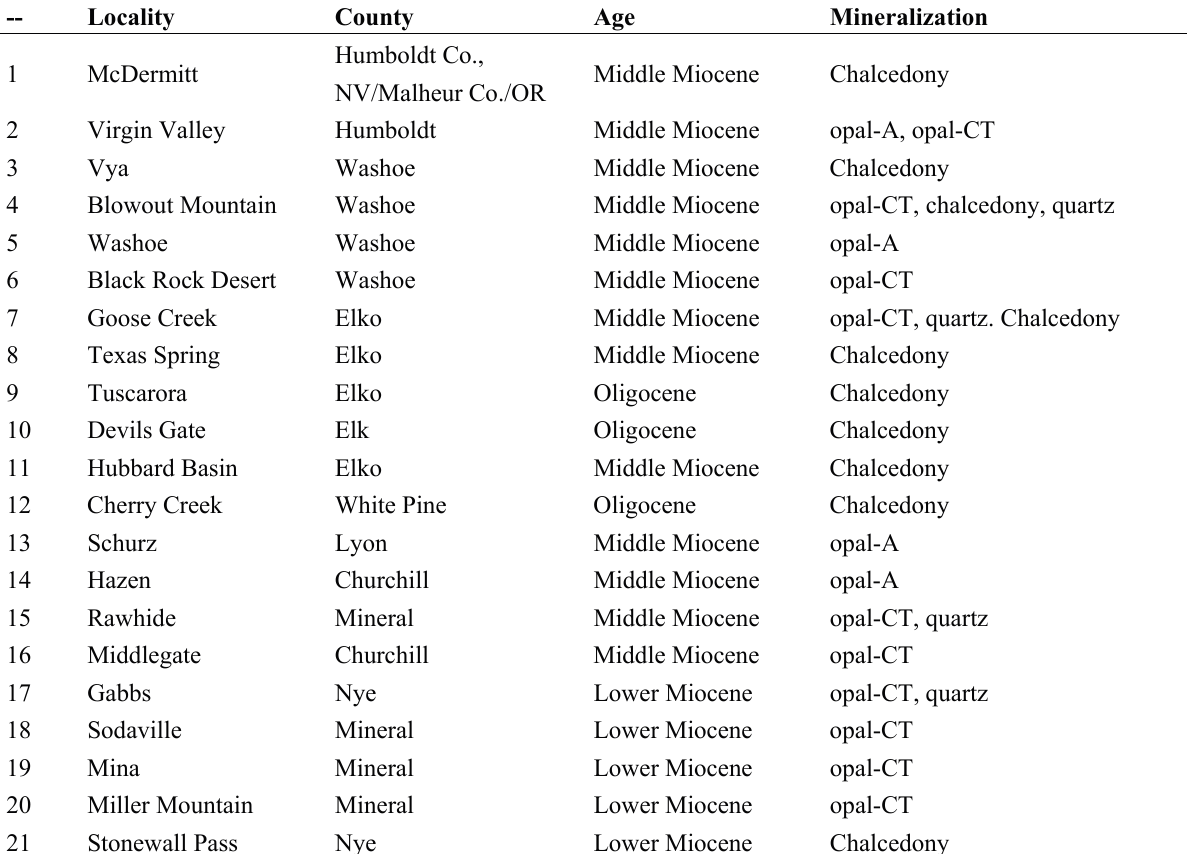
Table 1. Localities for petrified wood specimens used in this study (Figure